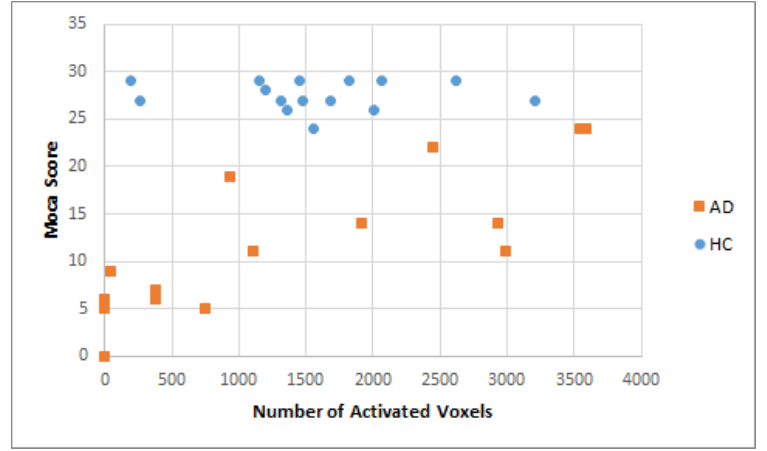
Figure 5. Number of activated voxels related to MoCA score in AD and HC groups (threshold value > 3.4).